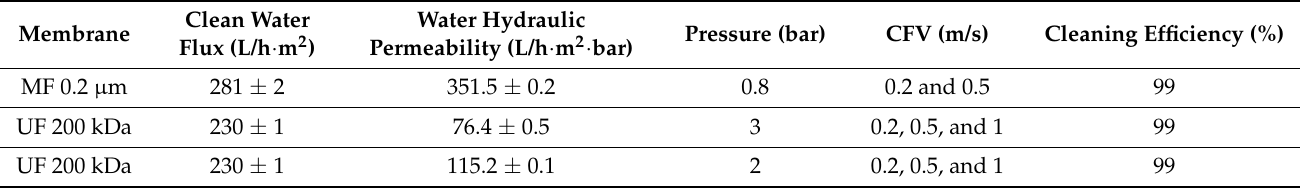
Table 3. Clean water fluxes and hydraulic permeabilities (Lp) of each membrane using distilled water at 25 ◦ C, including the cleaning